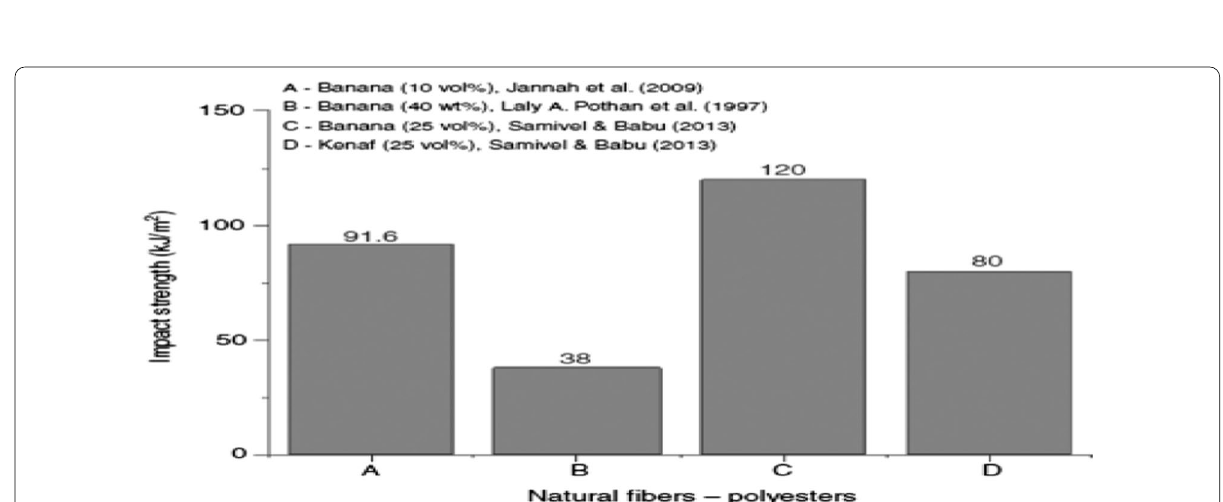
Fig. 6 Impact strength of natural fibre-reinforced polyester (Kulkarni et al.